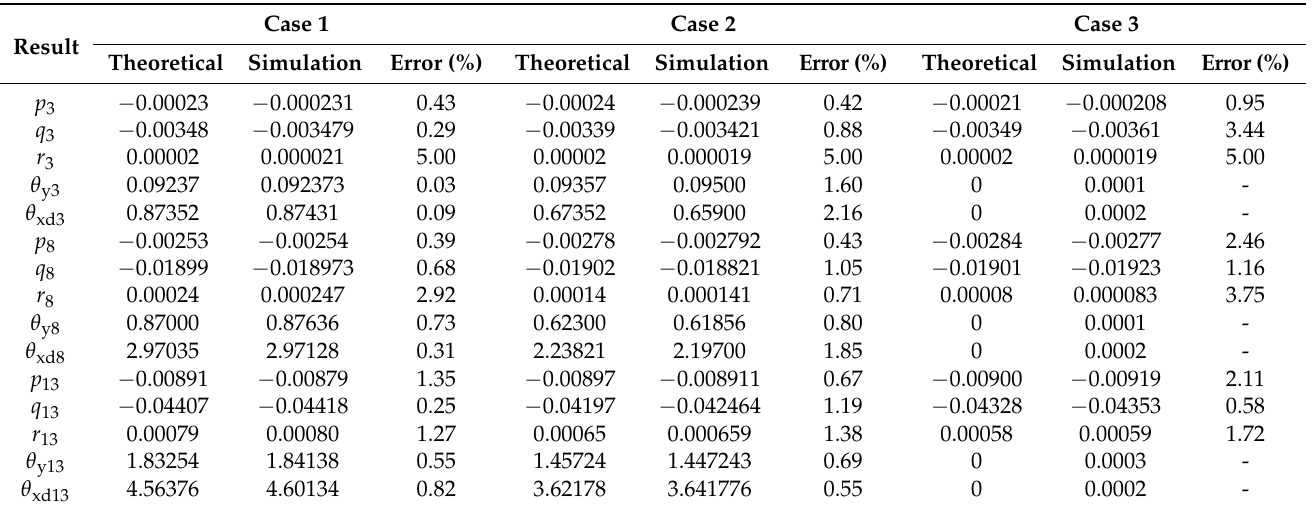
Table 7. Theoretical and simulation results of the displacement and rotation angle of points ( P 1 , P 2 , P 3 ).